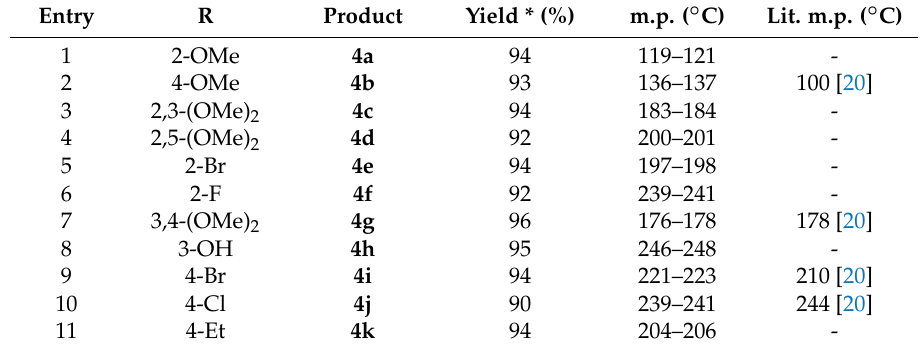
Table 4. Synthesis of novel functionalized pyridine derivatives by 2.5% Ag 2 O/ZrO 2 catalyst a